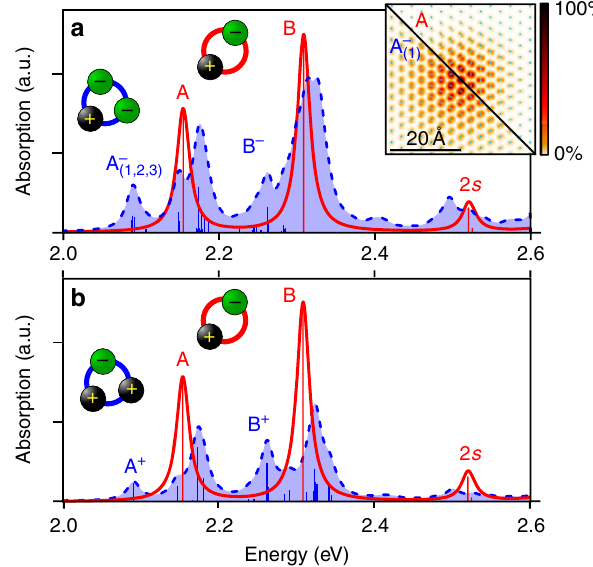
Fig. 1 Exciton and trion spectrum of an MoS 2 monolayer. The excitonic contribution to the optical absorption spectrum is shown in red. The trionic contribution (shown in blue, referring to negative trions in a and positive trions in b ) exhibits resonant states (close to the A and B exciton) and bound states (red-shifted compared to the corresponding excitons). The A − trion is split into three separate peaks, labeled A (cid:1) ð . The numerical 1 ; 2 ; 3 Þ recursion scheme 64 is used to calculate the energetically lowest states. For the spectra above 2.3 eV in a and 2.4 eV in b , the Haydock recursion scheme is applied. An arti fi cial broadening of 0.01 eV is used. Inset: comparison between the real space electron distribution (in arbitraty units) of the A exciton with the electron distribution from the A (cid:1) ð trion (see 1 Þ Supplementary Fig. 7 for details). For this, the hole is fi xed in the center of the panel close to a Mo atom, in which the distribution is shown. For the trion state, the distribution of one electron is shown after complete spacial averaging over the second